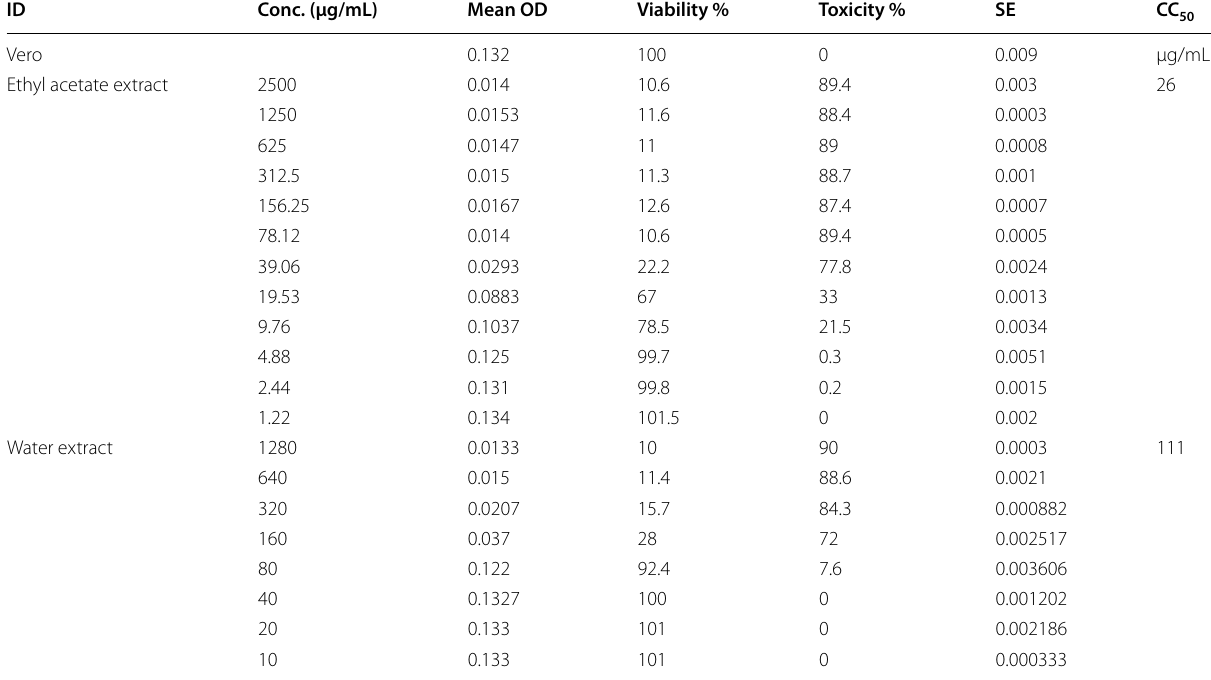
Table 5 Detection of maximum non-toxic concentration of the mushroom extracts against Vero cell (cytotoxicity) ID